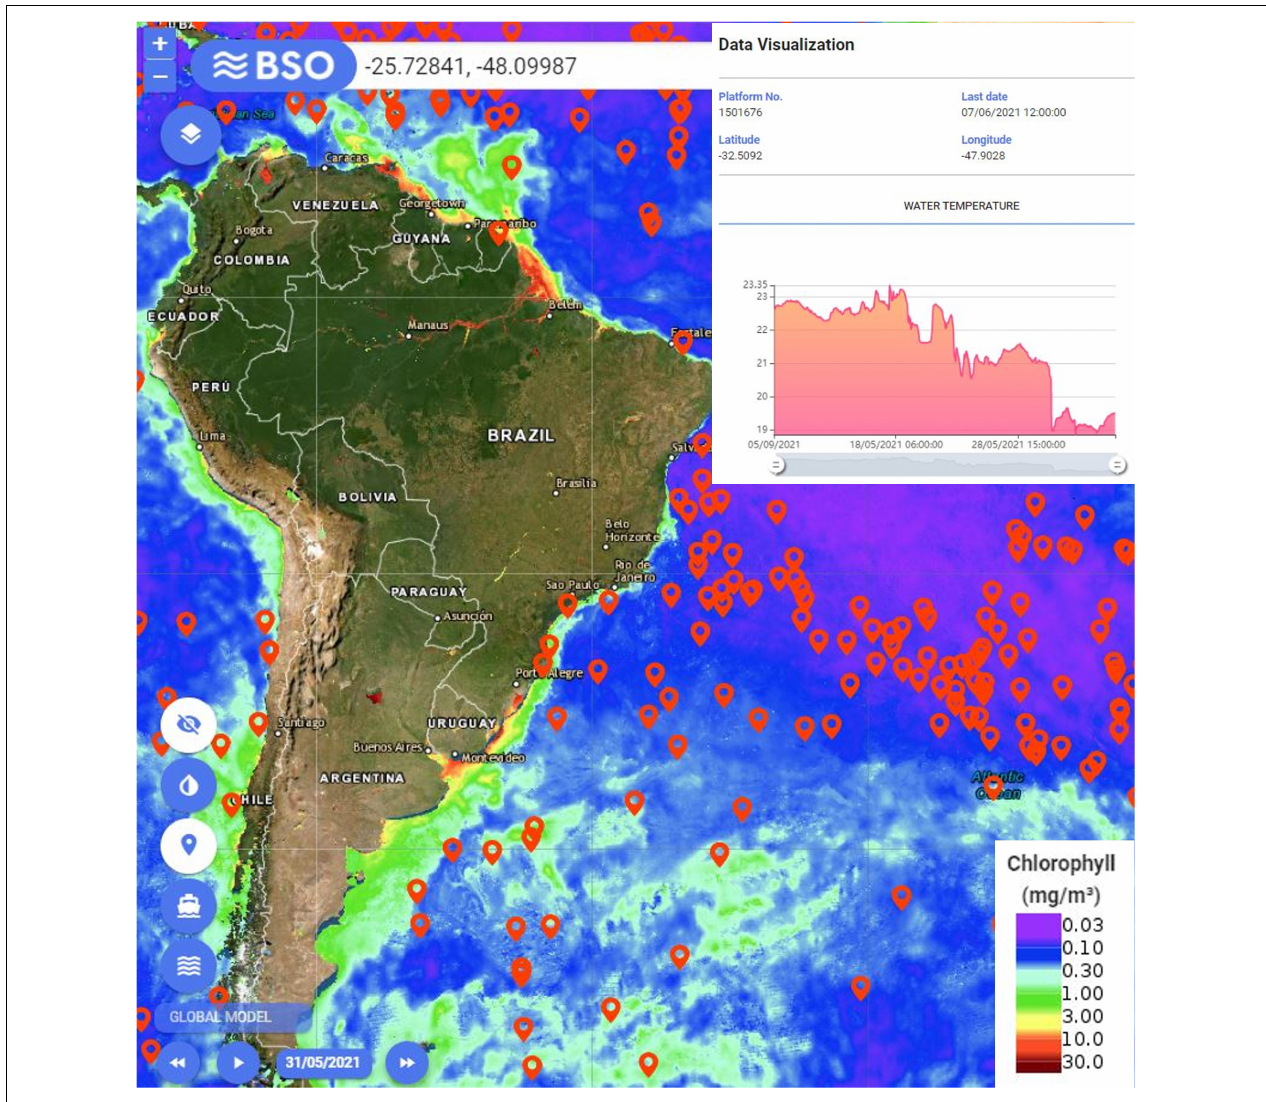
FIGURE 7 | View of the WebGIS platform: satellite data of chlorophyll, drifting floats location and graph with in situ